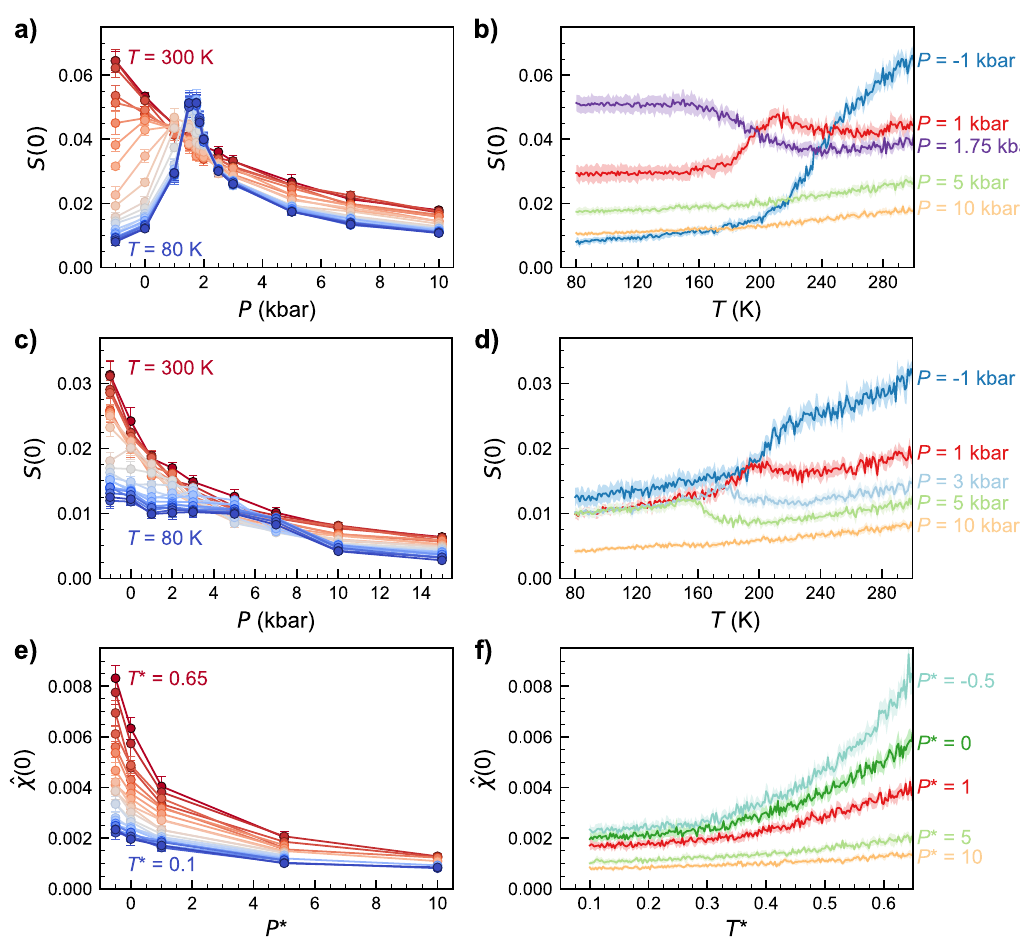
Fig. 1 Long-range structure during isobaric cooling trajectories at pressure P . Zero-wavenumber limit of the static structure factor ( S (0)) for TIP4P/ 2005 cooled at q T = − 1.0 K ns − 1 ( a , b ) and of mW cooled at q T = − 10.0 K ns − 1 ( c , d ) and e , f spectral density ( ^ χ (0)) for KA at q T = − 5.55 × 10 − 6 τ − 1 . In a , c , e , colors denote different temperatures, ranging from T = 300 K (red) to T = 80 K (blue) in steps of 10 K for a , c and T * = 0.65 (red) to T * = 0.1 (blue) in steps of 0.0025 for e . In b , d , f , colors denote select pressures as marked. Error bars in a , c , e or shaded regions in b , d , f denote 95% con fi dence intervals obtained from the standard error of the (Fig. 1e, f) we plot the spectral density ( ^ χ ( k )) at zero wavenumber,